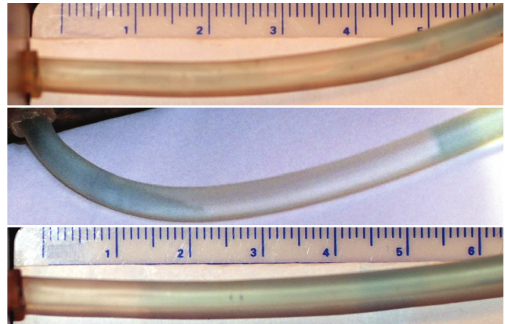
Figure 4: Terminal tube at the board containing coloured water and uncoloured LG. The upper panel shows a 55 mm plug after injection of 0.3mL LG with the cannulation method using the LeGoo cannula which was retracted during injection. There are traces of water in the plug corresponding to the path that formed on cannula retraction, and the border between water and LG plug is indistinct. This plug lasted only one minute. The middle panel shows a 32 mm plug after injection of 0.2 mL LG through a LeGoo cannula without retraction during injection. There is water on both sides of the plug showing that the plug had formed unnecessarily deep into the tube. The lower panel shows a 33mm plug after retrograde injection of 0.15mL LG. The plugs in the middle and lower panels were observed for 20 minutes without observing any